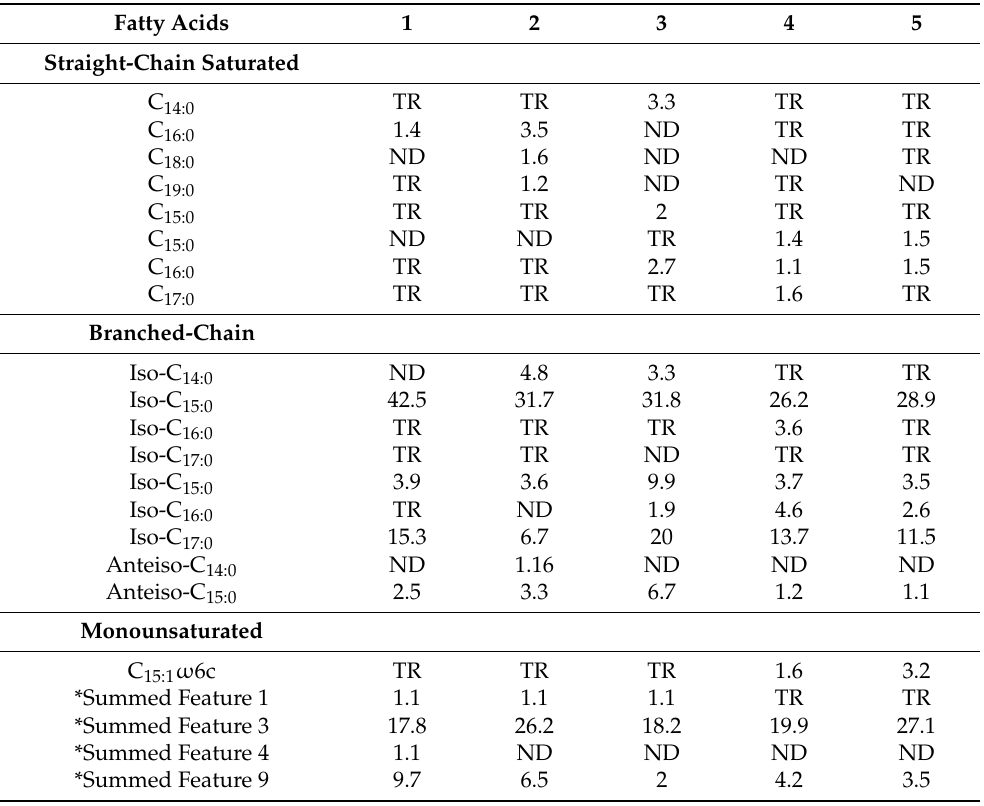
Table 4. Fatty-acid compositions (%) of the strains and the reference species of the genus Pedobacter . Fatty